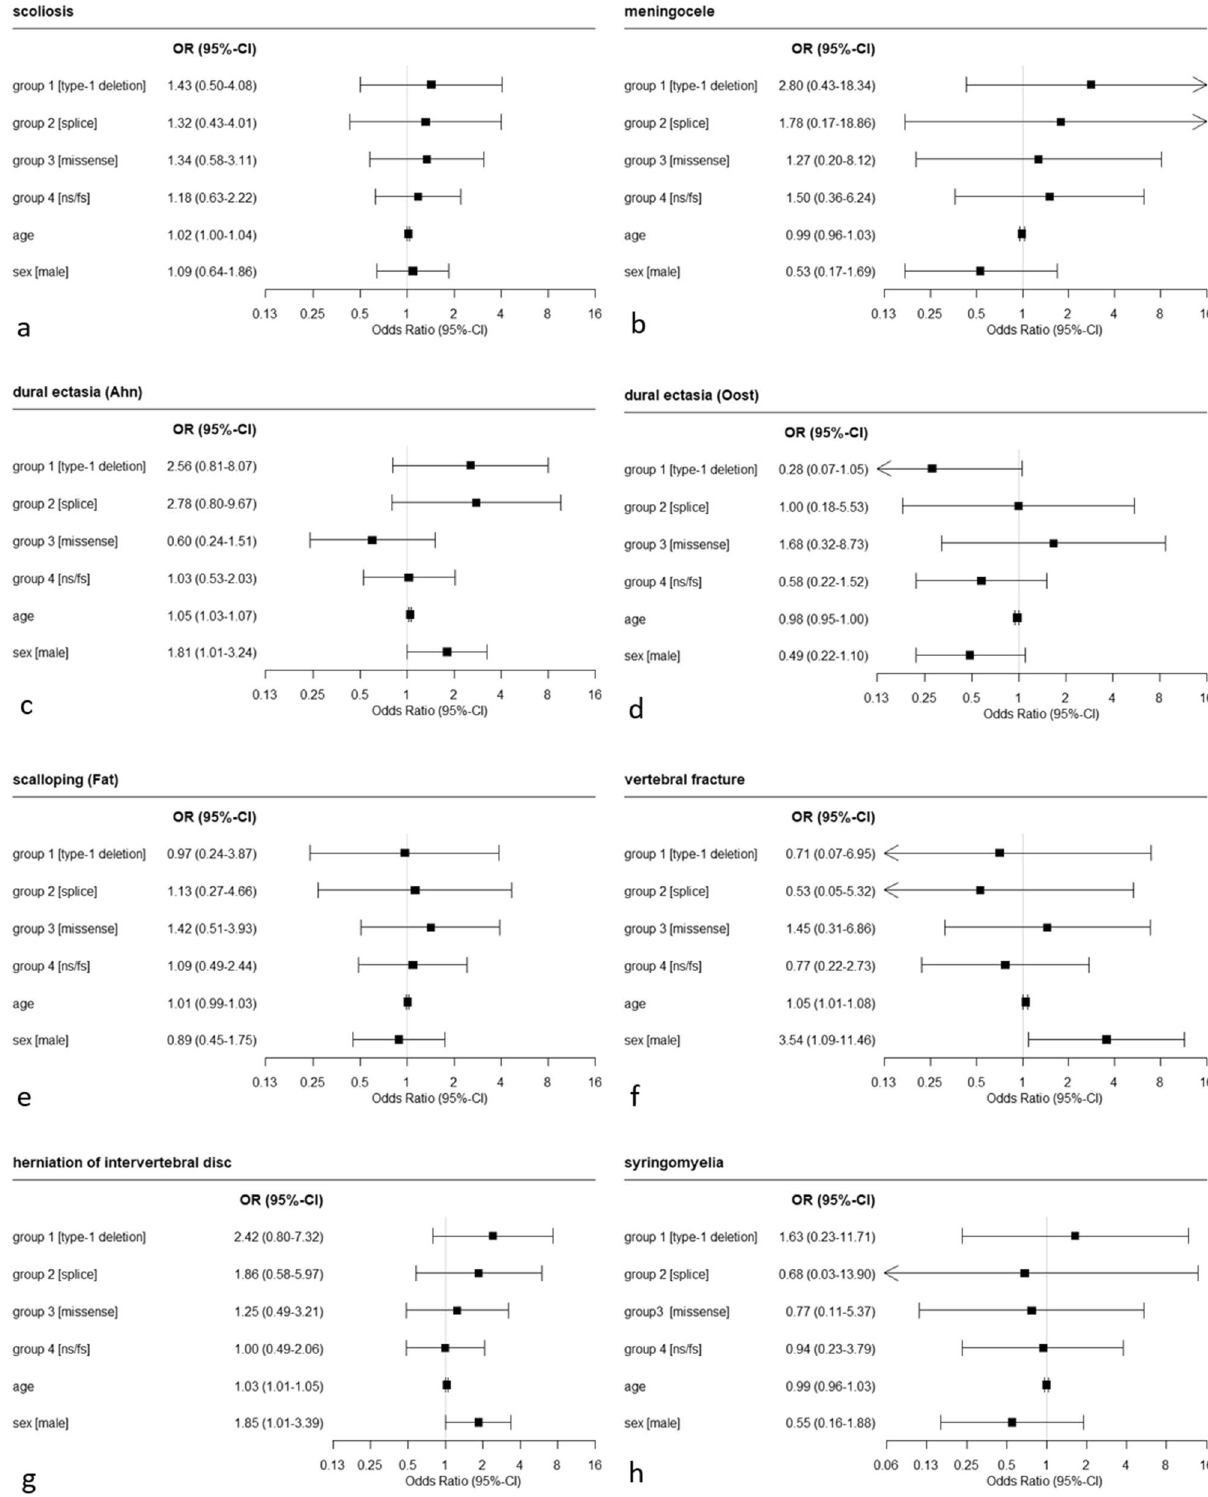
Figure 2. Results of logistic regression analysis on the association of spinal abnormalities with type of mutation of the NF1 gene, age and